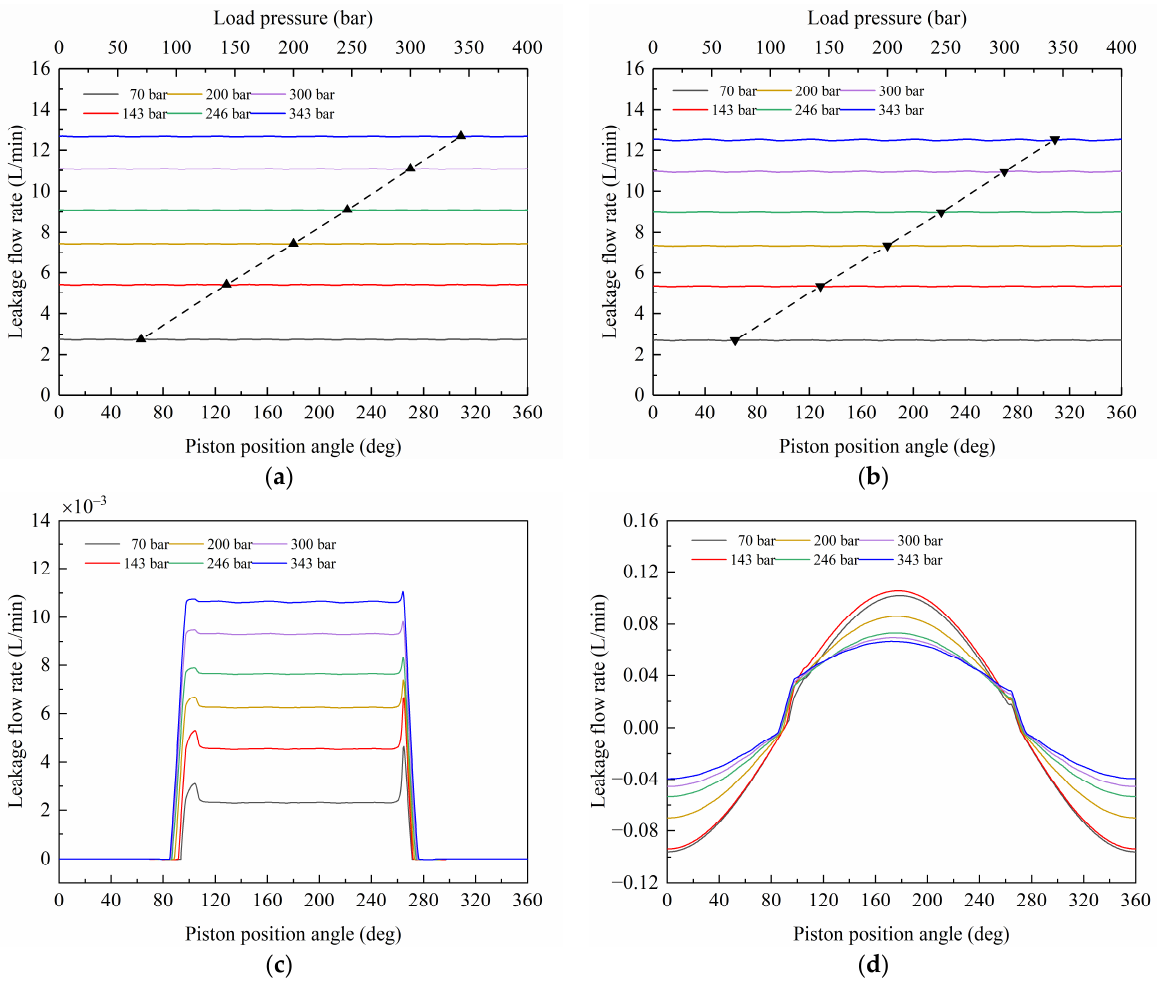
Figure 25. Leakage flow of the piston pump and kinematic pairs under different load pressures: ( a ) leakage flow rate of the piston pump; ( b ) leakage flow rate of the port plate–barrel block pair; ( c ) leakage flow rate of the slipper–swash plate pair; ( d ) leakage flow rate of the piston–barrel block pair.